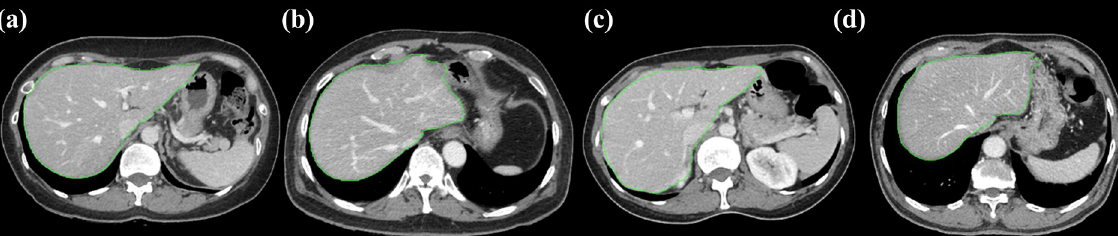
PLOS ONE | https://doi.org/10.1371/journal.pone.0271724 July 20,